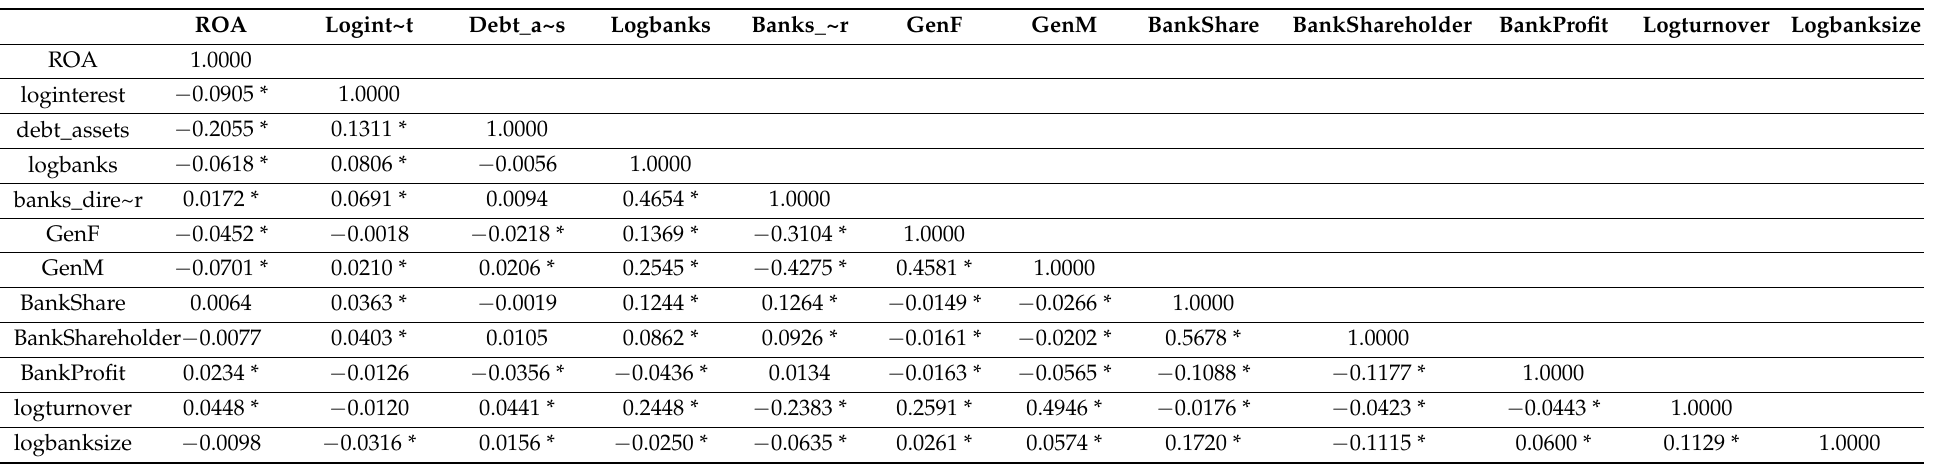
Table 5. Pearson correlation